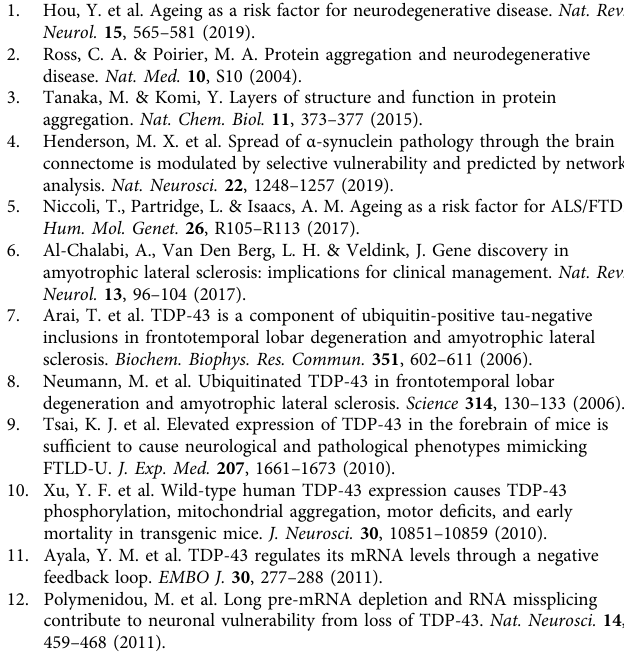
Supplementary Table 2. The thermal cycling conditions for the probe assays were as follows: 95 °C for 10min, 40 cycles at 94 °C for 30s and 55 °C for 2min (ramping rate reduced to 2°C per second), and a fi nal step at 98 °C for